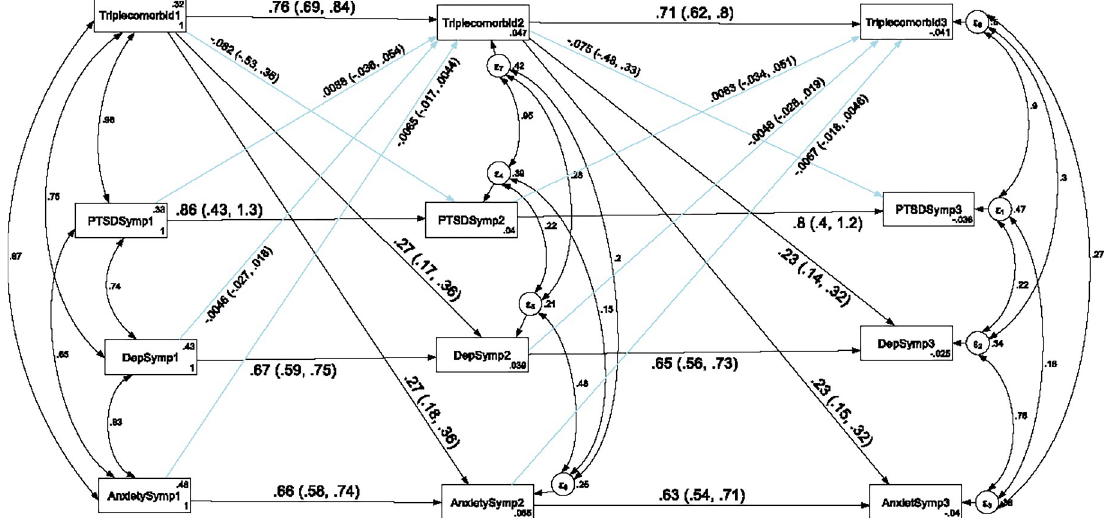
Fig 5. Longitudinal stability and cross-lagged association of depression, anxiety and PTSD with multimorbidity of anxiety, depression and PTSD. Note : All β ’s are standardized estimates with 95% CI.